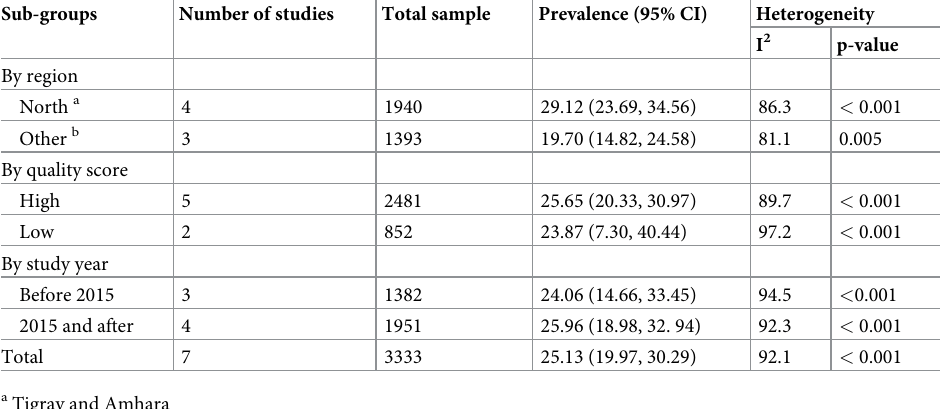
Table 3. Subgroup analysis of the prevalence of unmet need for family planning among women living with HIV in Ethiopia,